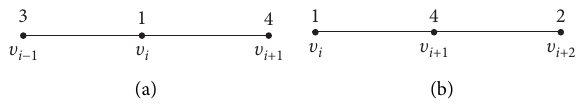
Figure 4: A path with three nodes and their surjective labels.